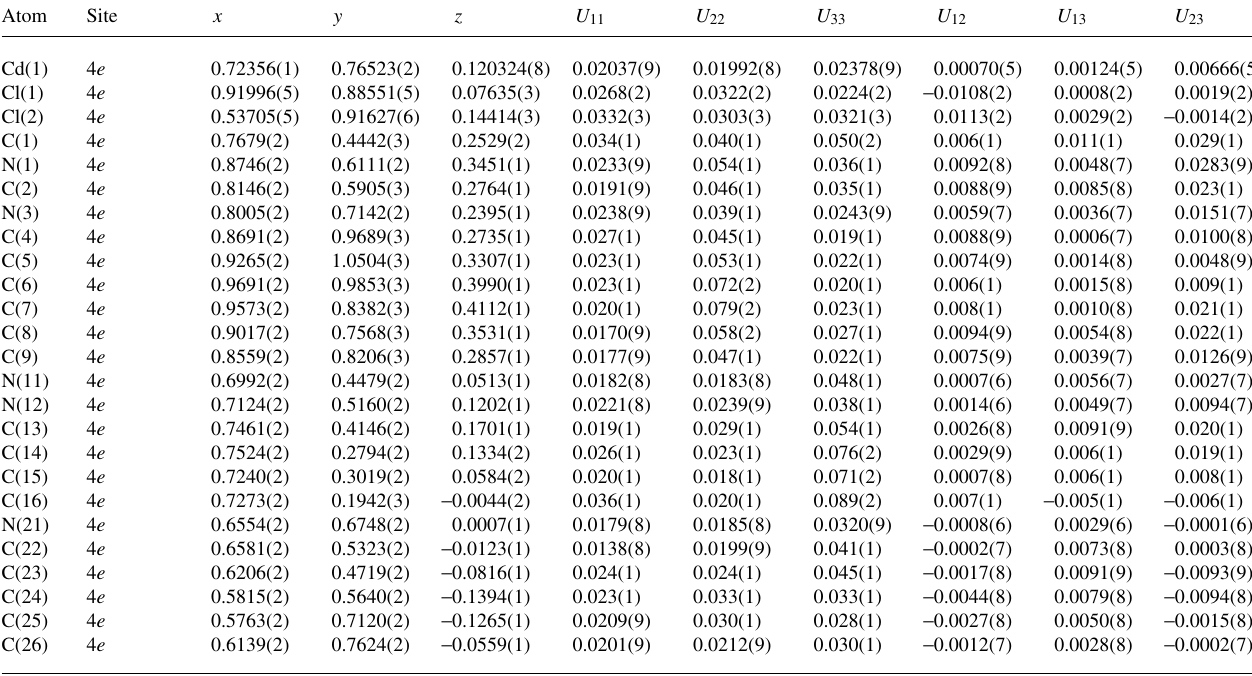
Table 3. Atomic coordinates and displacement parameters (in Å 2 ) .